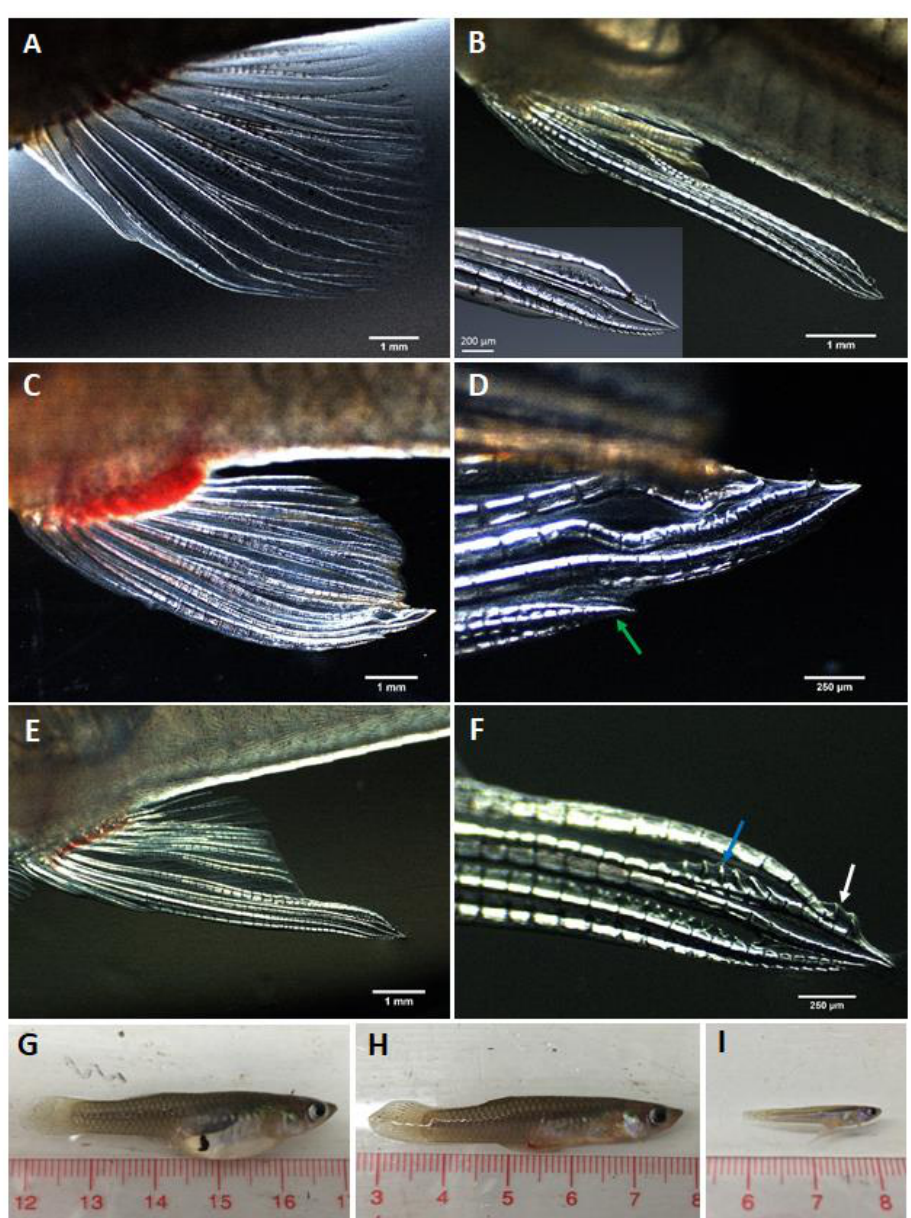
Figure 1. Shapes of anal fins and body shapes of control and MT-treated G. holbrooki. ( A ) The anal fin of a normal female, ( B ) and ( B -inset) the gonopodium (modified anal fin) of a normal male, ( C ) the curved short gonopodium-like structures of RG females treated with 75 mg MT/kg diet post 50-day treatment period and ( D ) the gonopodial tip of the treated females (at higher magnification) indicating that fin ray 3 (green arrow) did not completely elongate to combine with fin rays 4 and 5 to generate fully developed complex terminal structures. ( E ) The gonopodium-like structure of MG females treated with 75 mg MT/kg diet post 50-day treatment period and ( F ) its tip (at higher magnification) equipped with serrae (blue arrow) and hooks (white arrow). Body shapes of a typical female ( G ), RG female treated with 150 mg MT/kg diet post 50-day treatment period ( H ) and a typical male ( I ).